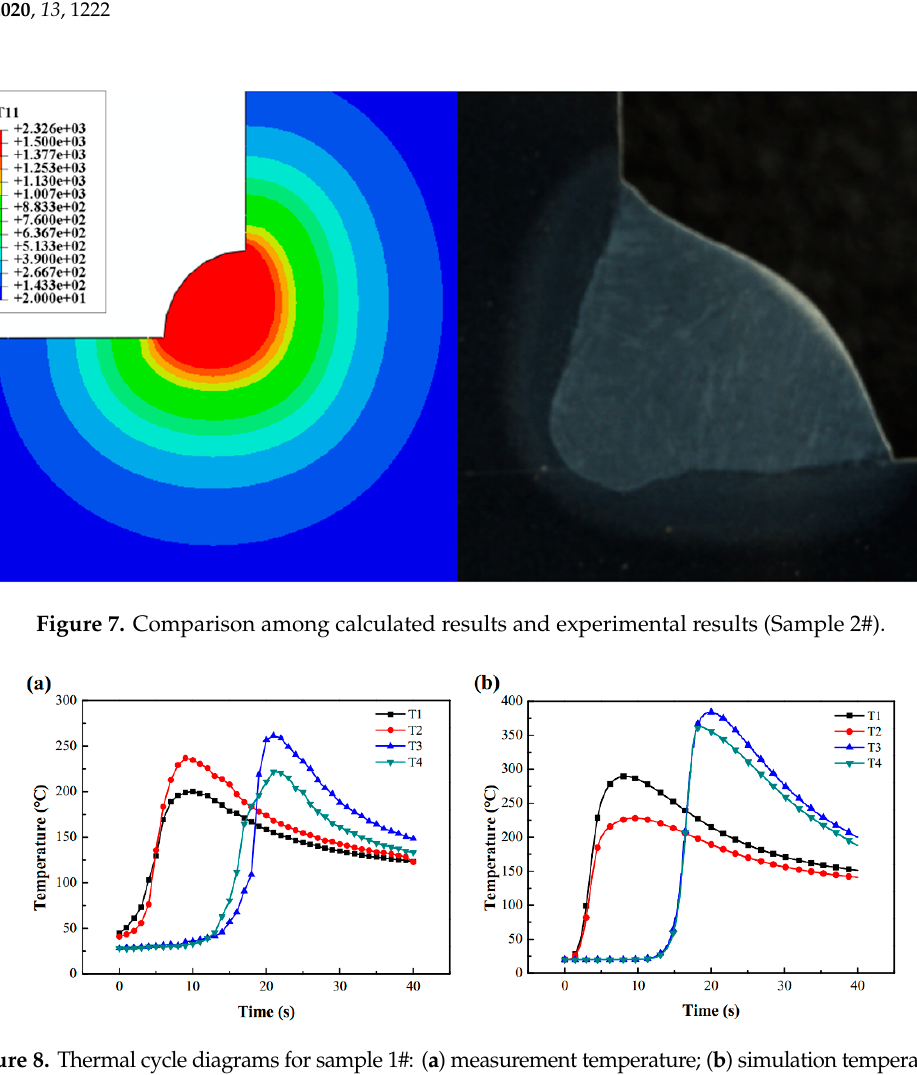
Figure 8. Thermal cycle diagrams for sample 1#: ( a ) measurement temperature; ( b ) simulation temperature.